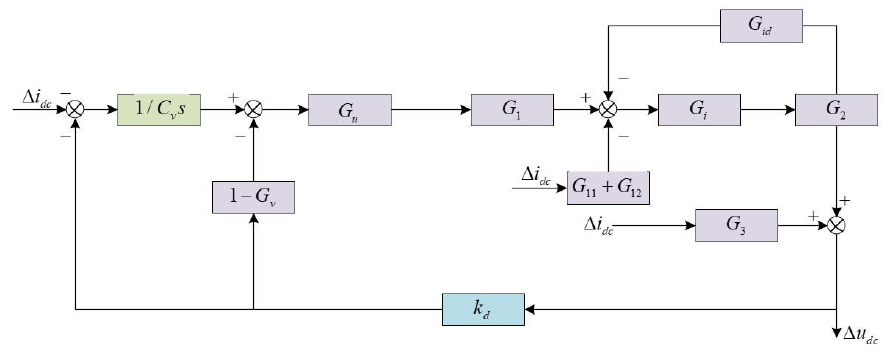
Figure 4. B-DC Small Signal Control Block Diagram Under VSG Control.